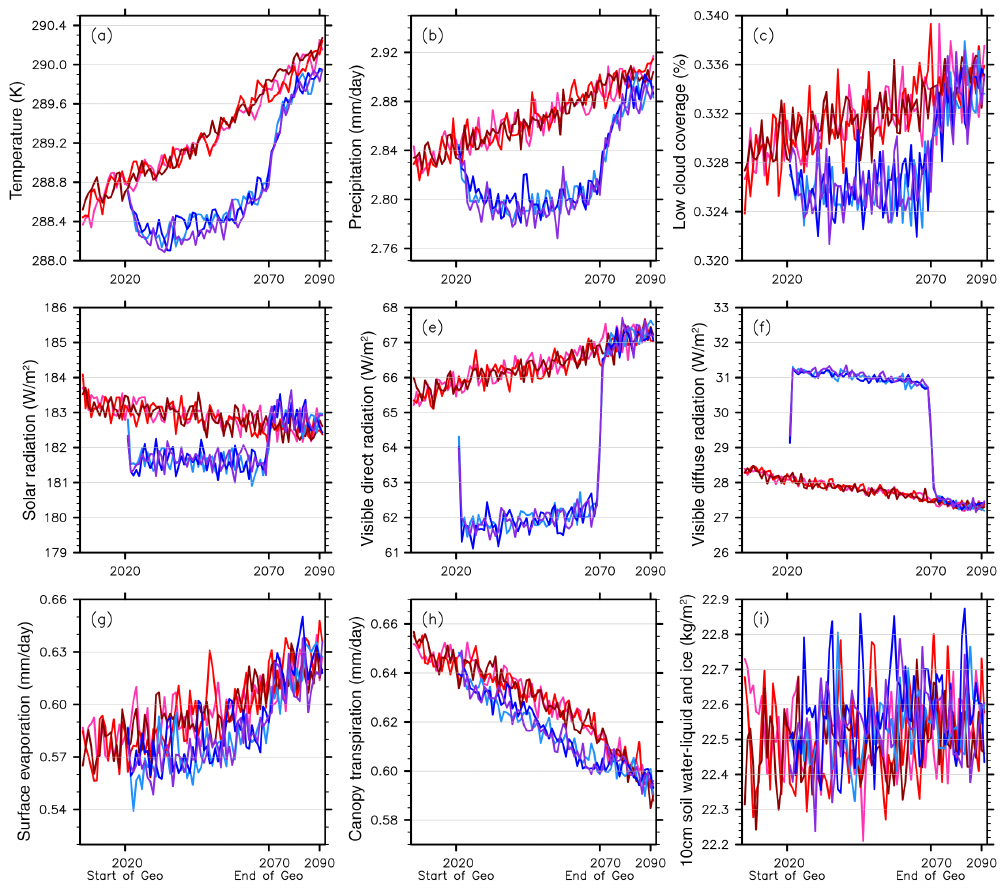
Figure 1. Global-average (a) temperature, (b) precipitation, (c) low cloud coverage, and (d) surface downward solar radiation under G4SSA sulfate injection geoengineering (blue lines) and under RCP6.0 (red lines). Land-average (e) surface downward visible direct radiation, (f) diffuse radiation, (g) surface evaporation, (h) canopy transpiration, and (i) vegetated land top 10cm soil water (liquid water and ice) content under G4SSA (blue lines) and RCP 6.0 (red lines). The three red lines and blue lines indicate three ensemble members of RCP6.0 and G4SSA. Sulfate injection starts at 2020 and ends at